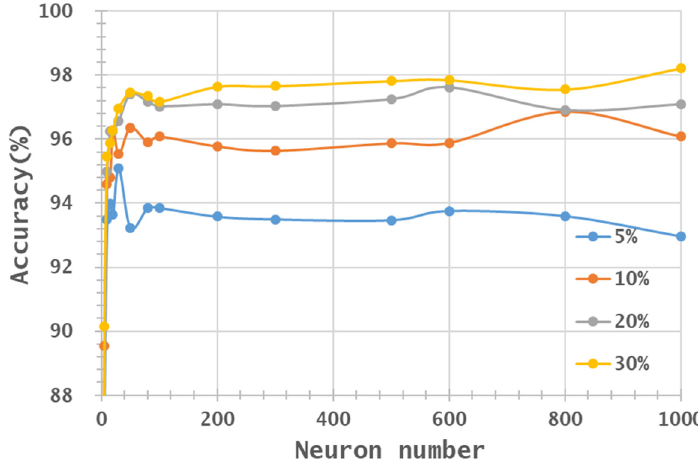
Figure 9. Accuracy distribution of PaviaU MNF1–10 + HHT image set, varying with training sample proportion and hidden layers.